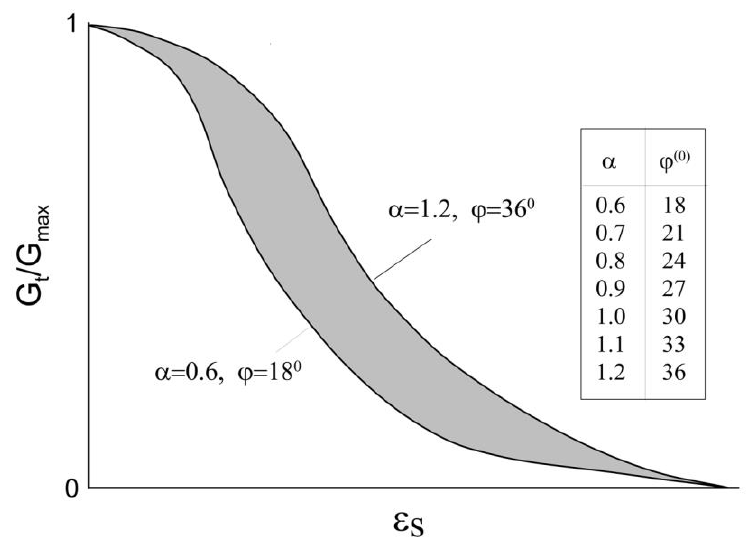
Figure 3. Influence of the parameter α on the S-shaped stiffness–strain curve inside the applicable range for normally consolidated states [16].